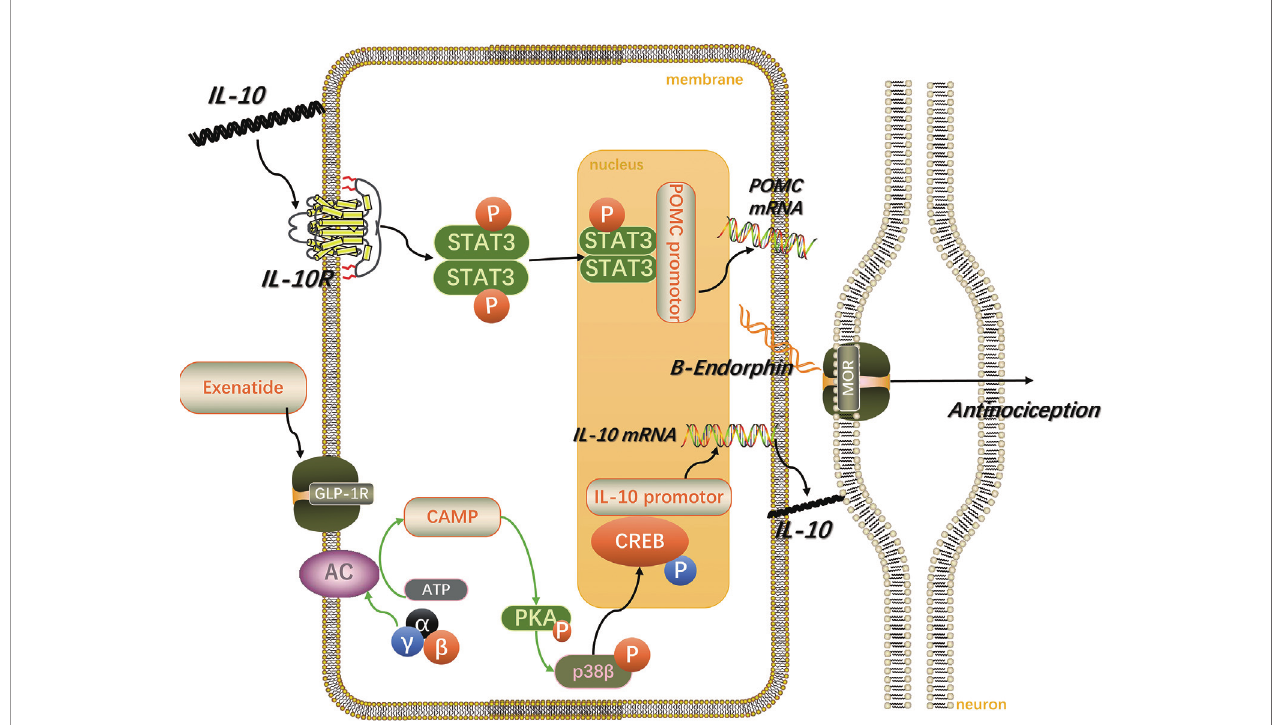
FIGURE 2 | Spinal microglia GLP-1R/IL-10/ b -endorphin analgesic pathway. IL-10 stimulates the GLP-1R activation-induced microglial expression of b -endorphin and neuropathic spinal cord anti-allergic response in an autocrine manner. The fi gure is modi fi ed from Ref